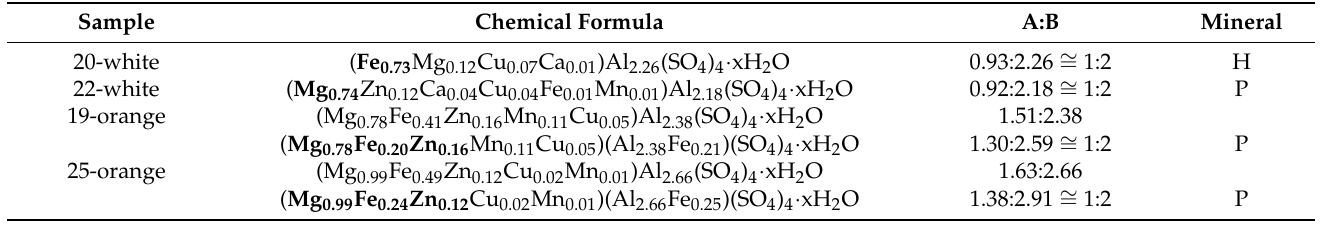
Table 5. Calculated chemical formula (based on SEM-EDS data) for the Algares samples from the halotrichite group, AB 2 (SO 4 ) 4 ·22H 2 O; x—number of water molecules; principal cations on A site are assigned in bold. H—halotrichite; P— pickeringite.